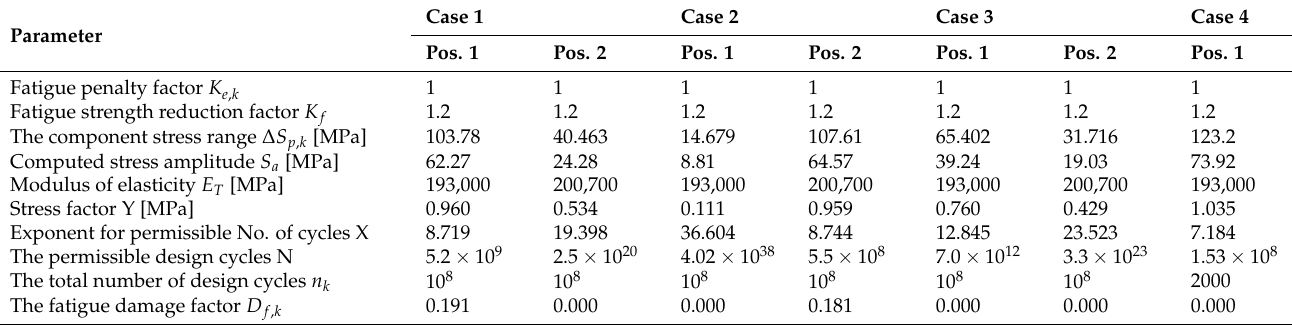
Table 4. Results for the finite element